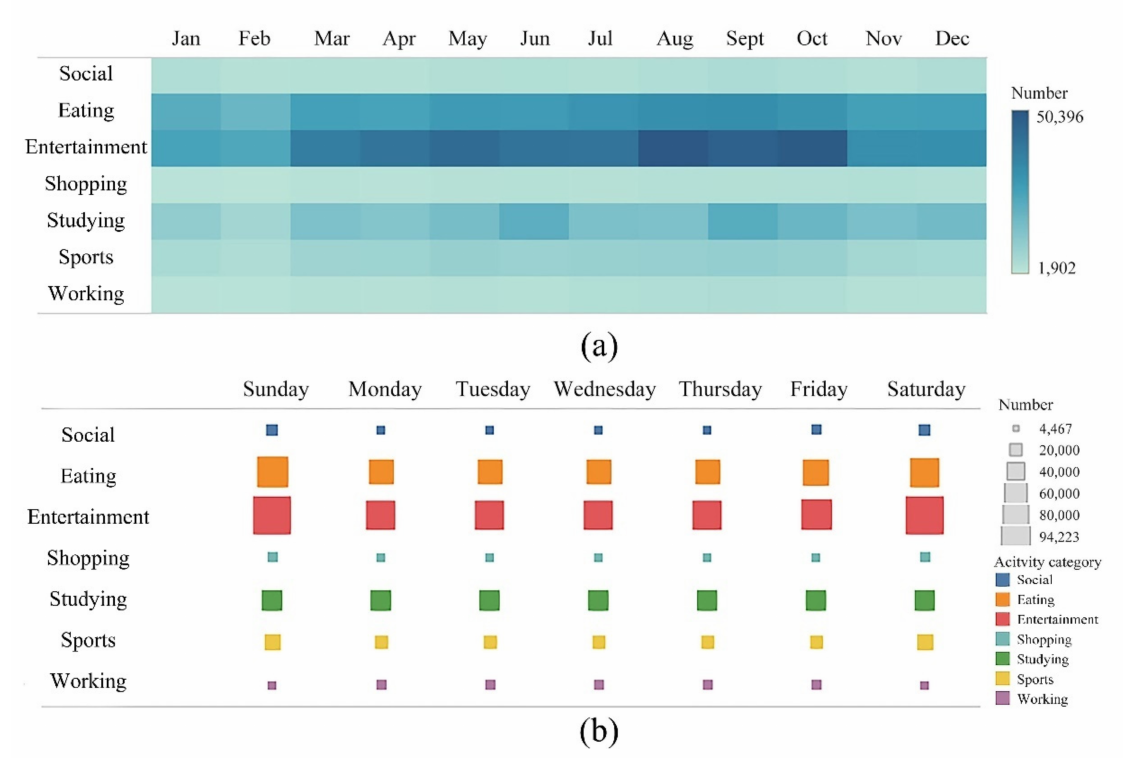
Figure 4. The ( a ) monthly and ( b ) daily temporal distribution patterns of residents’ daily